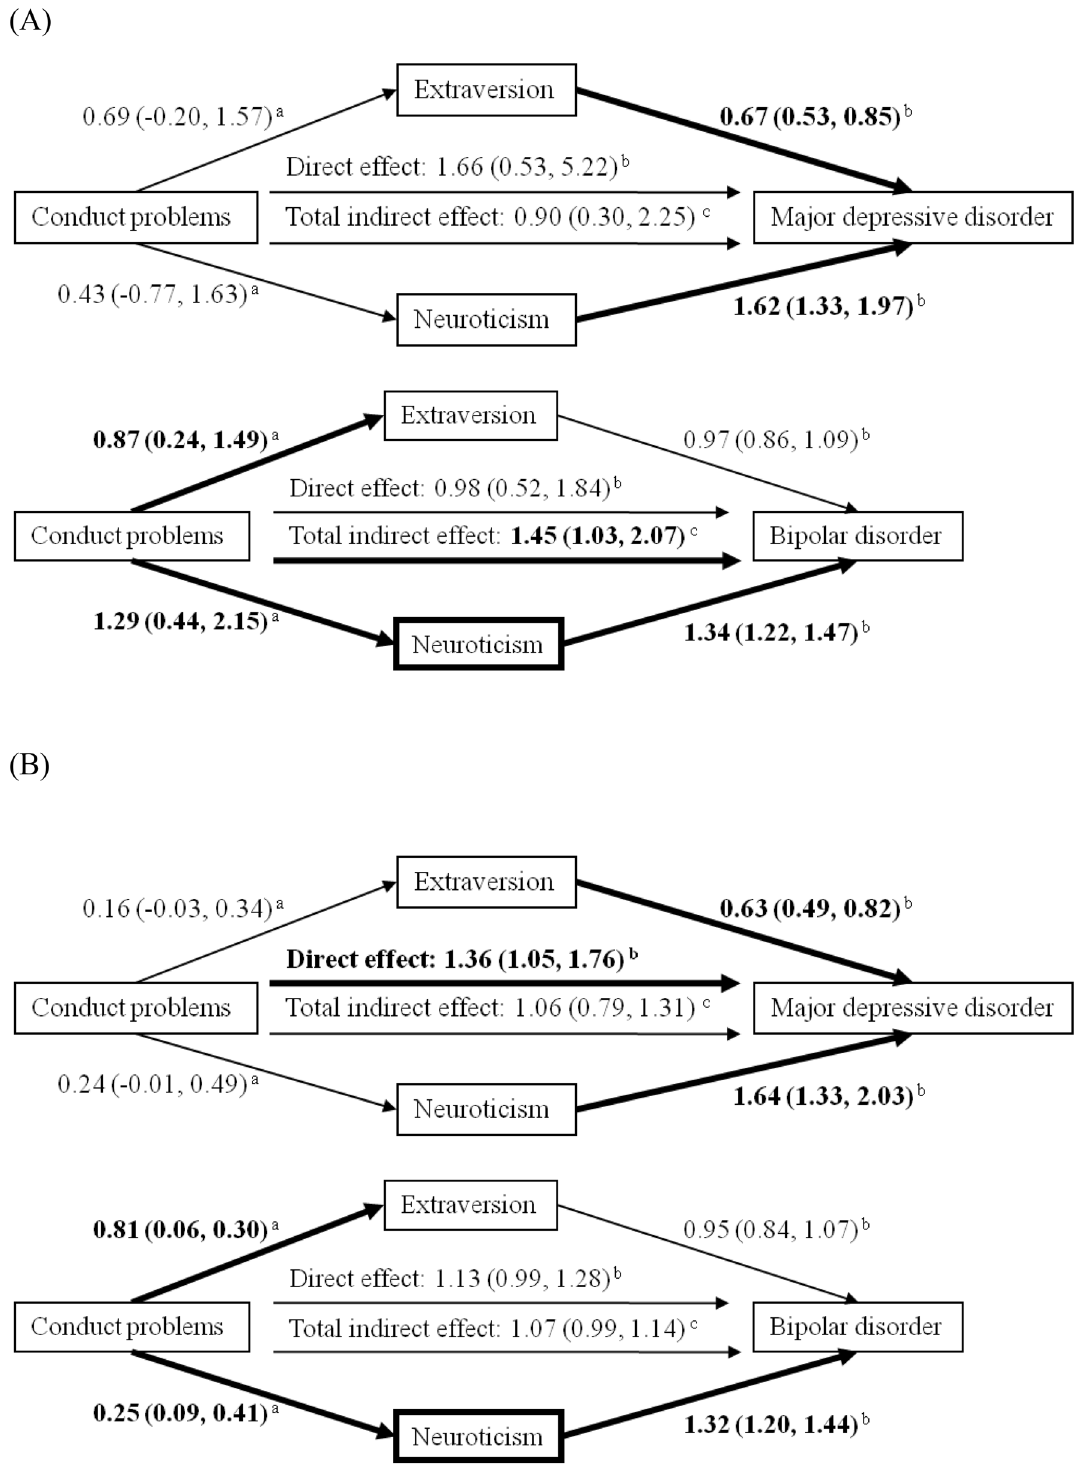
Figure 1. Pathways and corresponding coefficients of conduct problems correlated with mood disorders. (A) Effects of dichotomous conduct problems on psychiatric diagnoses mediated by extraversion and neuroticism. (B) Effects of total numbers of conduct problems on psychiatric diagnoses mediated by extraversion and neuroticism. a Coefficients and their 95% confidence intervals on the linear regression analysis. b Odds ratios and their 95% confidence intervals on the logistic regression analysis. c Odds ratios and their bias-corrected and accelerated 95% confidence intervals on the logistic regression analysis. Bold lines indicated pathways with statistical significance. All models were controlled for the covariates of age, sex, marital status, education status, job, and alcohol